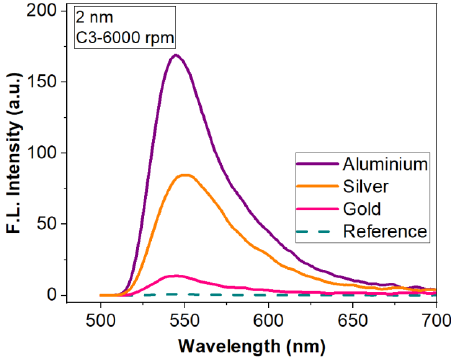
Figure 6. Fluorescence enhancement for three types of metasurface (nanostructured 2 nm-thick Al, Ag and Au thin films) for R6G:PMMA- C 3 thin film deposited at 6000 rpm.